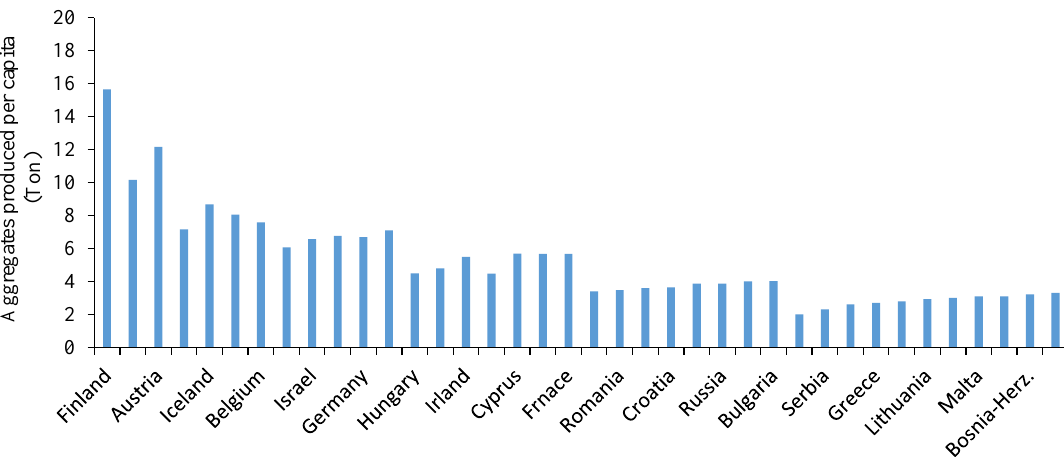
Figure 1. Aggregates production (tonnes) per capita by EU countries [3].